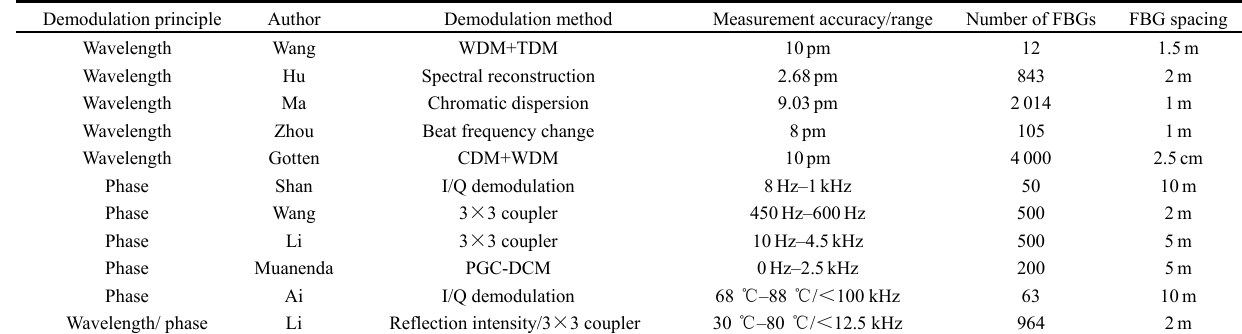
Table 2 Representative demodulation method of FBG